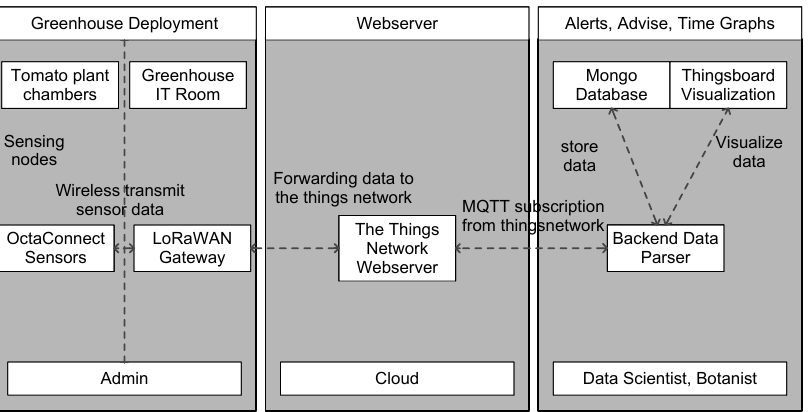
Figure 3. Architecture of the LoRaWAN-based sensor deployment and end-to-end data flow for a greenhouse monitoring